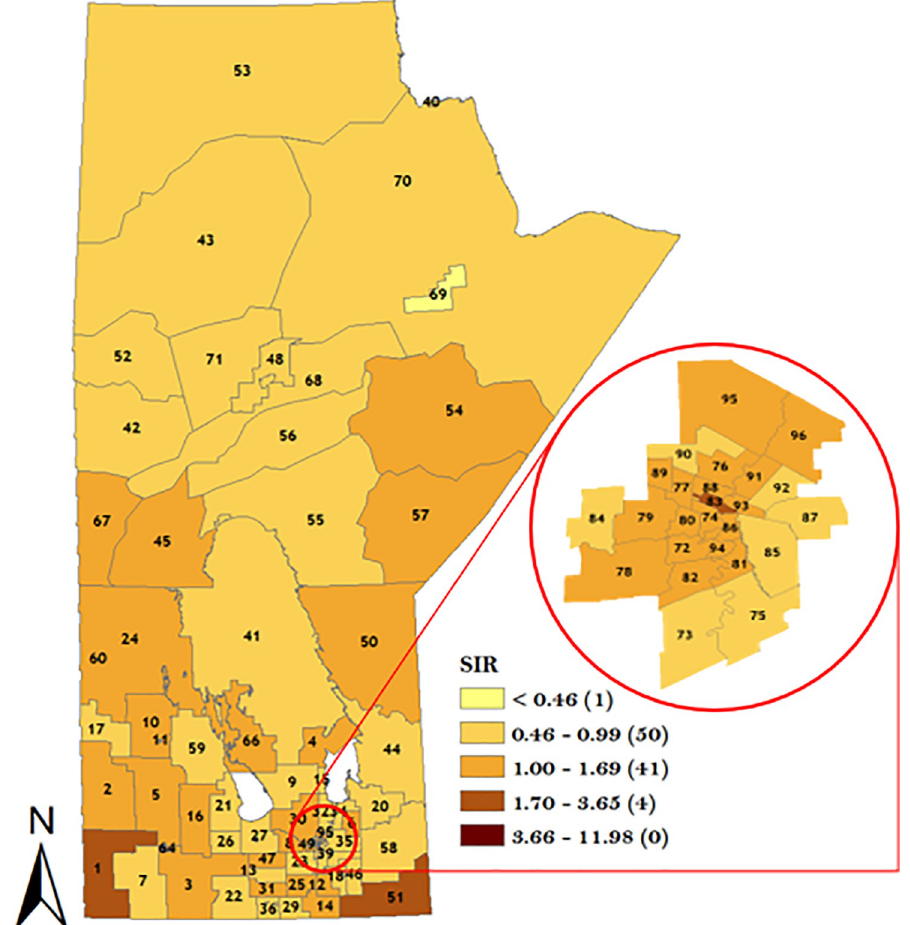
Fig 10. Map of standardized IRR of overall NCGC in Manitoba using Poisson regression model. Numbers in the map are the district labels from 1 to 96. Number of districts in each risk category is shown in parenthesis in the